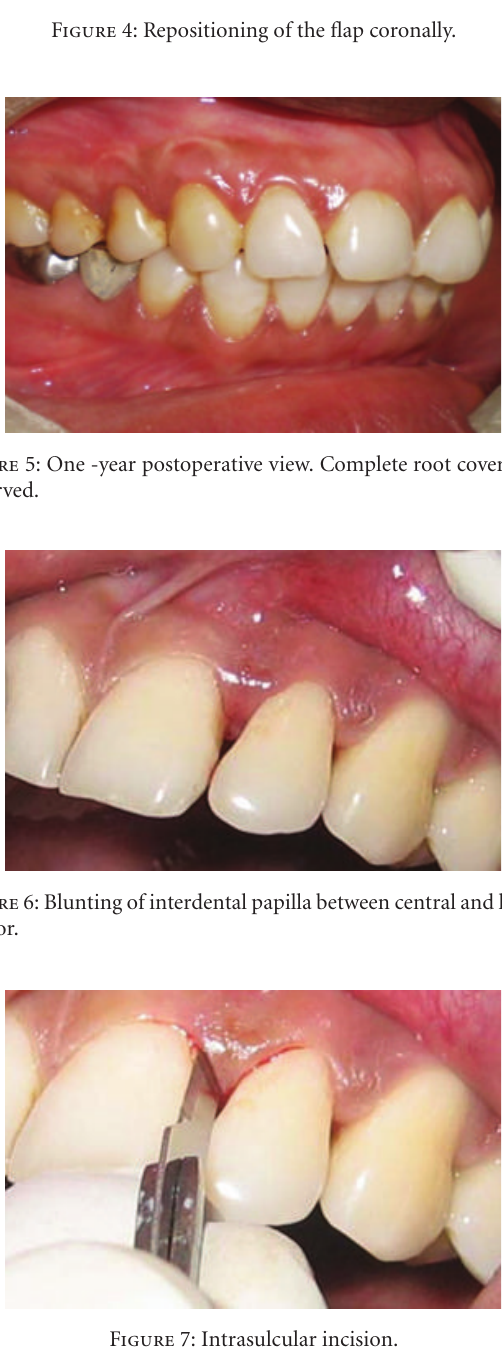
Figure 4: Repositioning of the flap coronally.